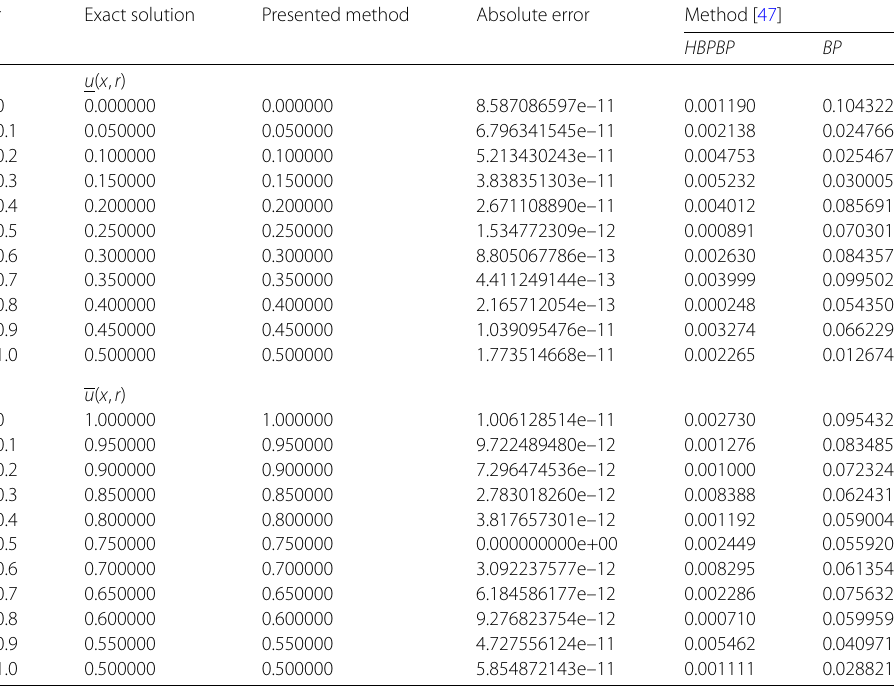
Table 2 The numerical results for Example 2 with x = 0.5, M = 2, N = 3 r Exact solution Presented method Absolute